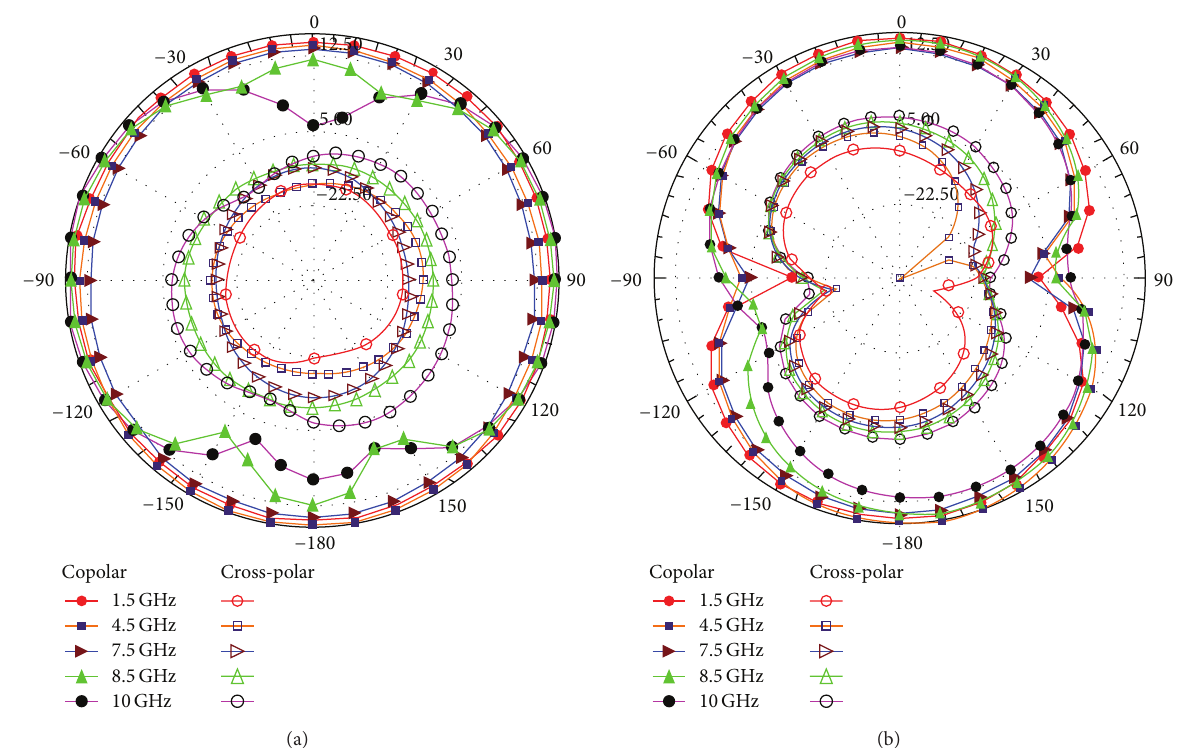
Figure 10: Radiation patterns at some frequencies: (a) x - z plane (H plane) and (b) y - z plane (E plane).